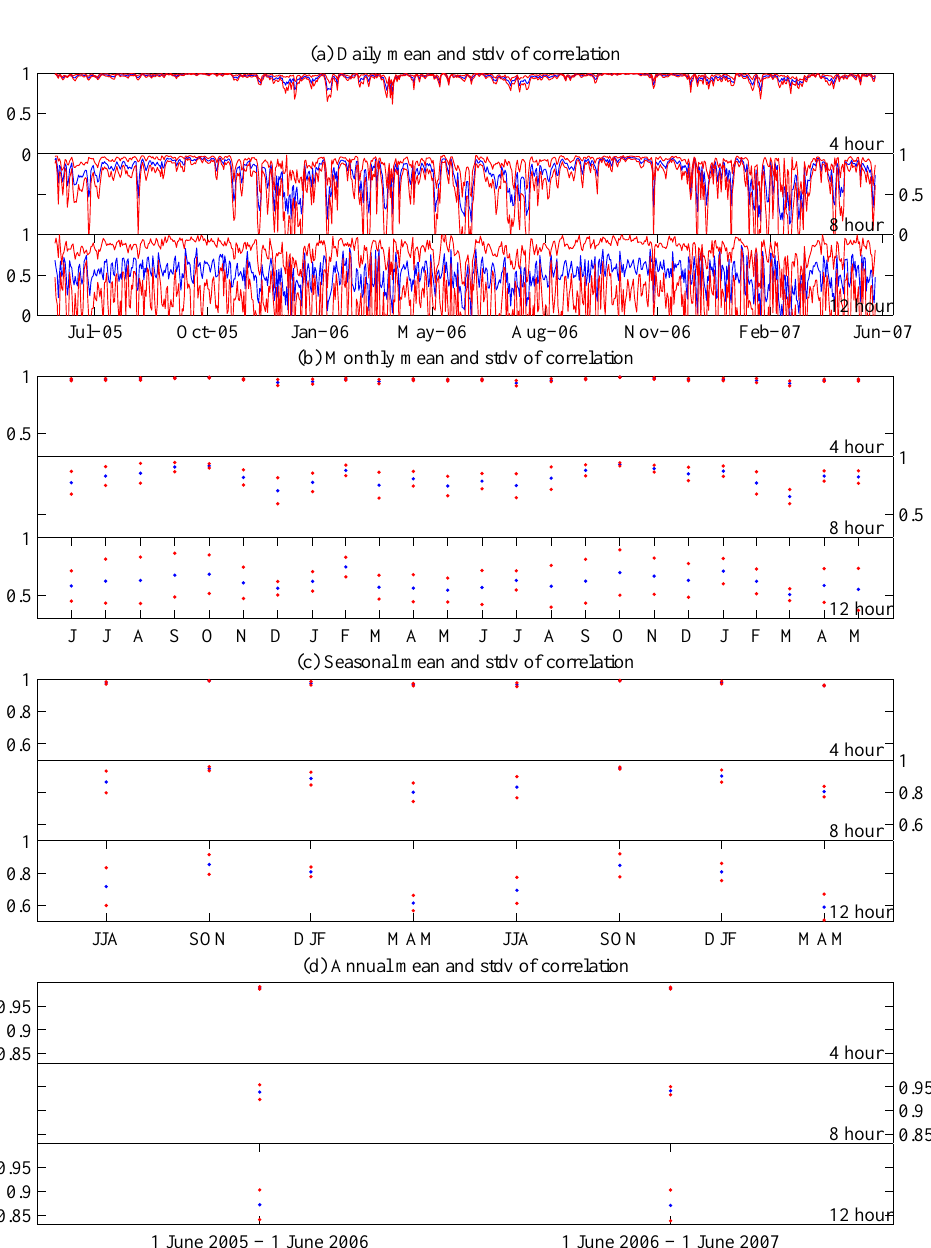
Figure 10. As for Figure 6, ( a ) daily; ( b ) monthly; ( c ) seasonal and ( d ) annual intervals, but showing R n and R n ± σ R , n . Table 1. Means and standard deviations of the normalized errors for the daily